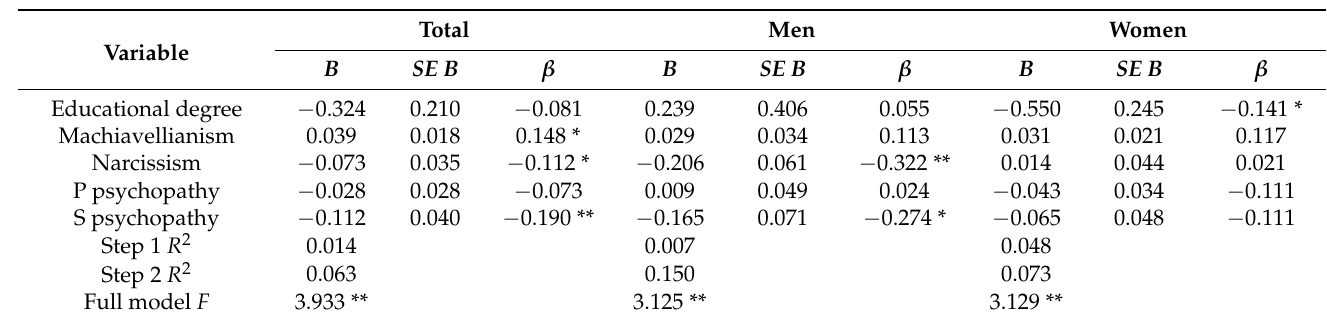
Table 5. Multiple regression of Dark Triad traits on emotional eating by sex.